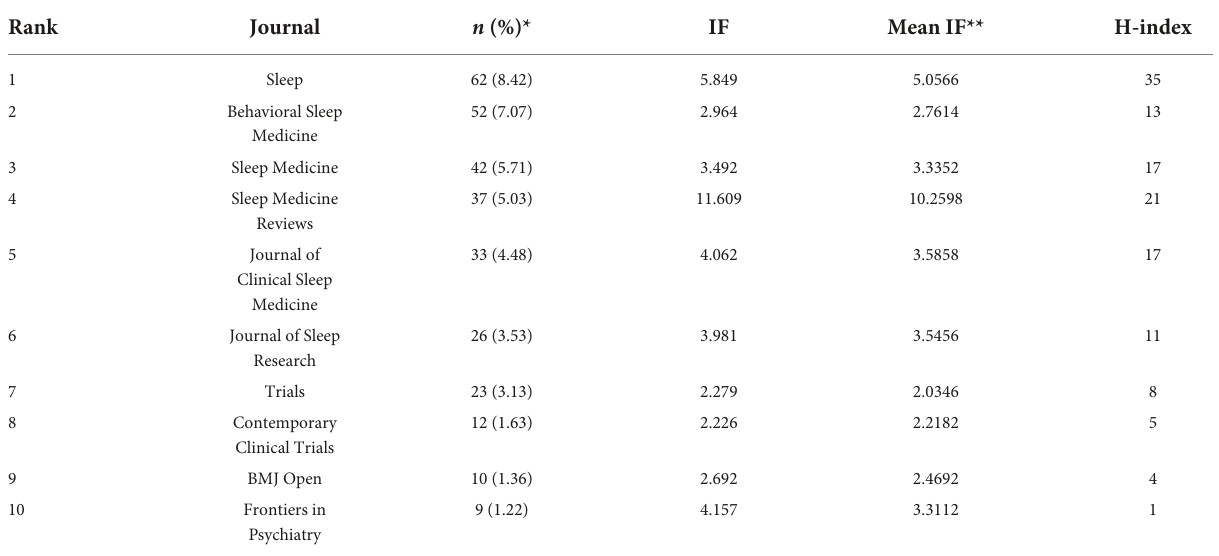
TABLE 1 Top 10 journals publishing papers on